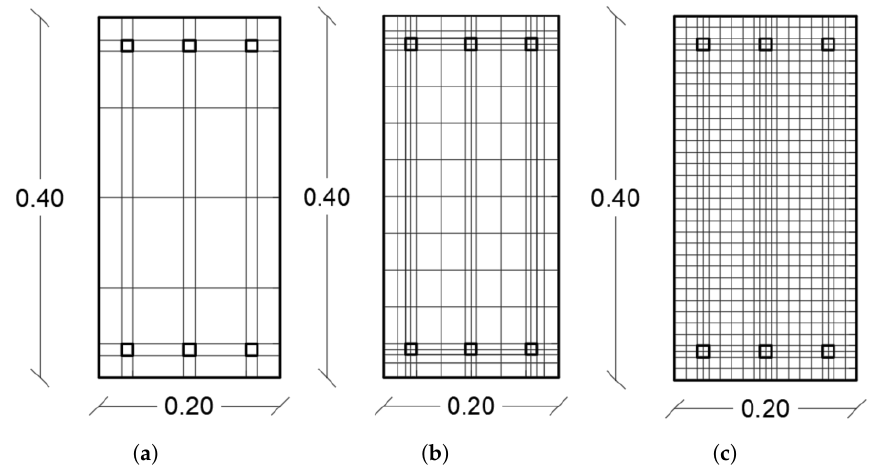
Figure A1. Different cross sections used. ( a ) Coarse, ( b ) Medium, and ( c ) Fine. Table A1. Mesh